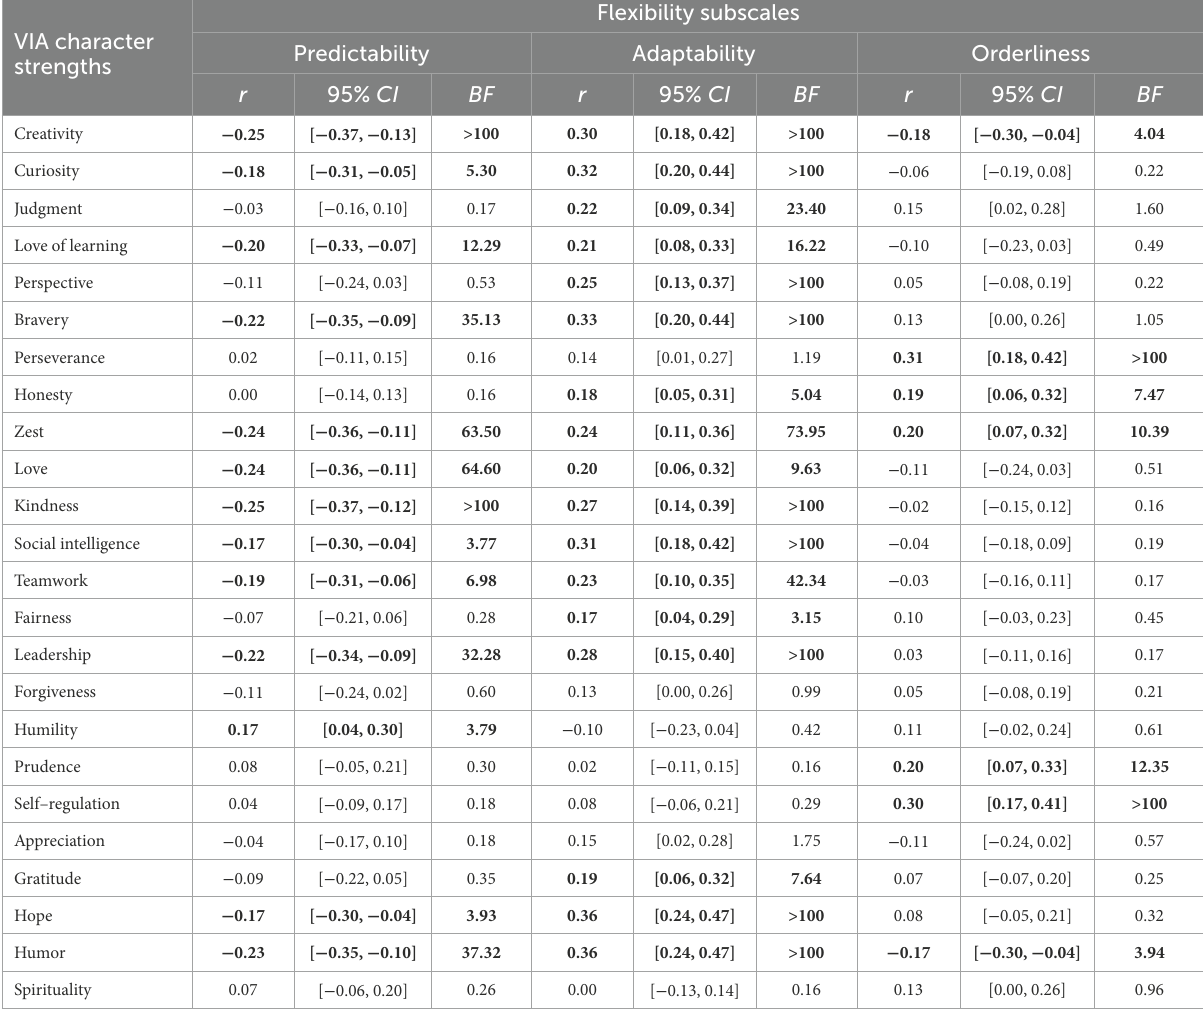
TABLE 1 Study 1: Pearson correlations between flexibility and VIA character